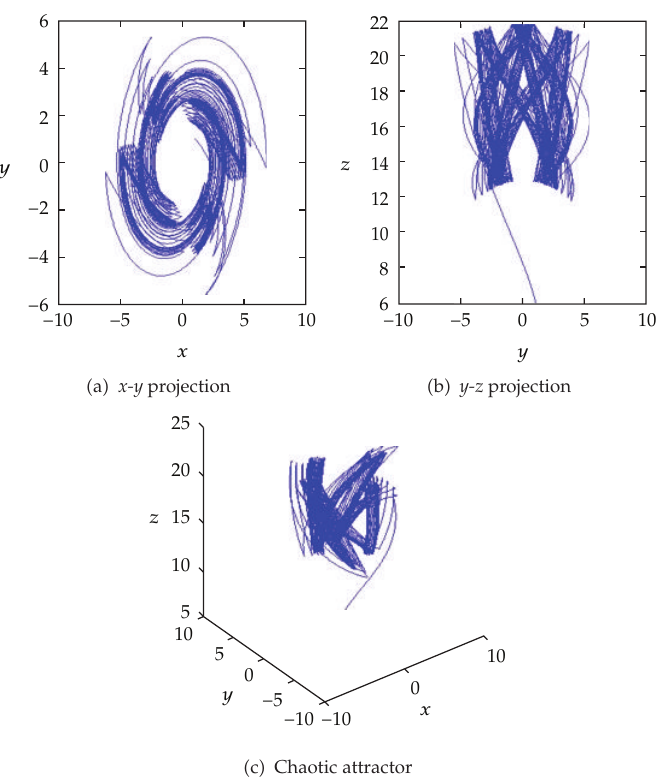
Figure 7: Chaotic attractor generated by F 1 (cid:7) 48, F 2 (cid:7)